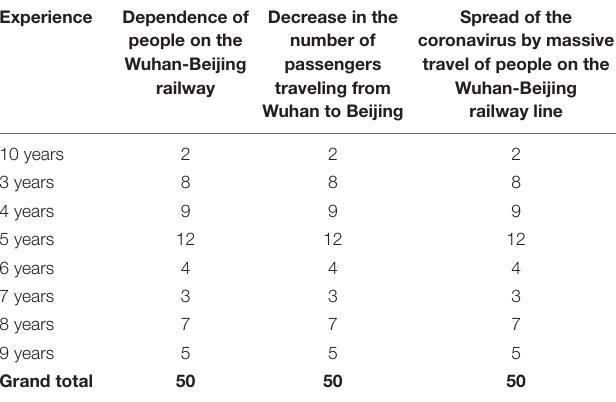
TABLE 3 | Passenger flow on the Wuhan-Beijing railway line and the spread of the coronavirus.